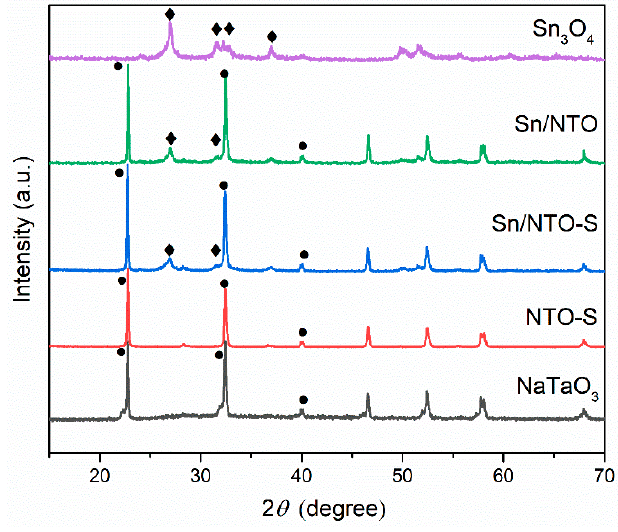
Figure 1. XRD patterns of as-obtained samples: NaTaO 3 , NTO-S, Sn/NTO, Sn/NTO-S composites, and Sn 3 O 4 .